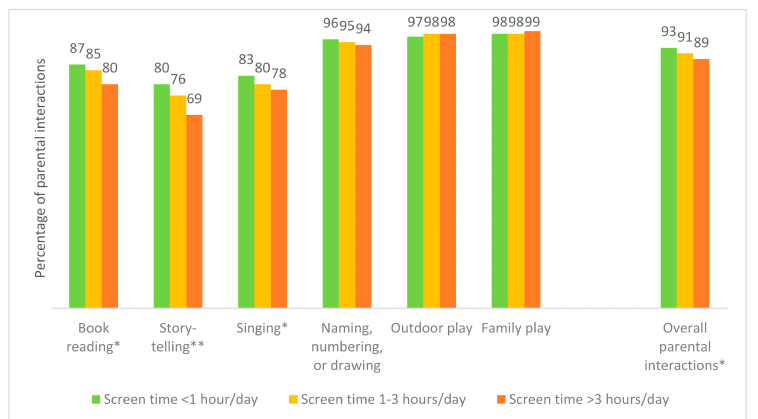
Figure 2. Percentage of the parental interactions by screen time duration. * p -value < 0.05, ** p -value < 0.01 (for each type of parental interactions and each range of screen time duration).